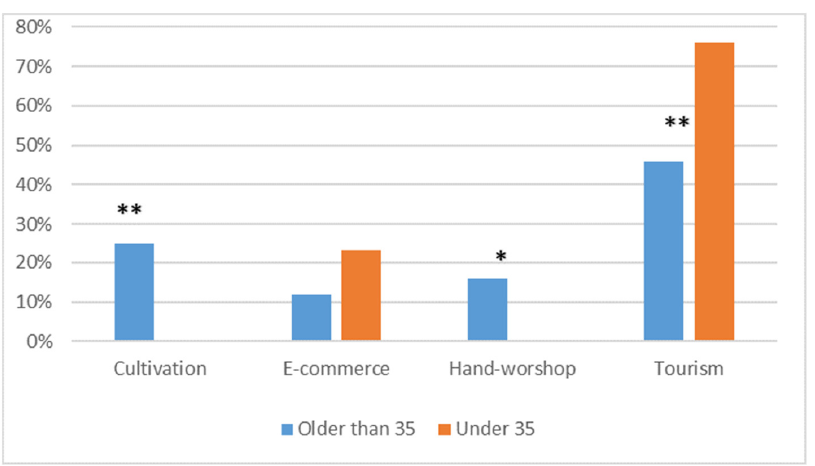
Figure 8. Variations in future industry, as perceived and preferred by female and male respondents. Asterisks indicate significance level: ** means p ≤ 0.01.